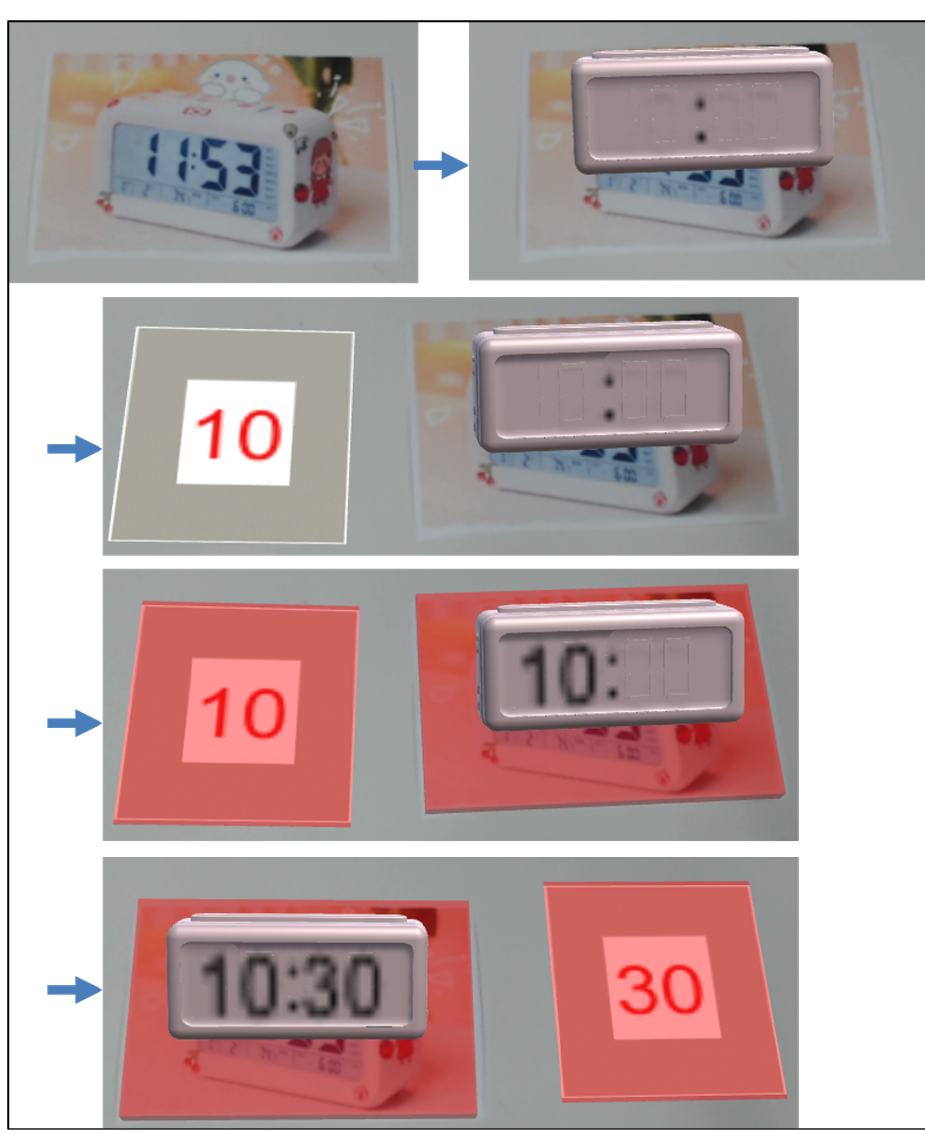
Figure 10. Using markers to control the virtual timer. The first picture shows the virtual timer marker. The second picture shows the initial state of the virtual timer superimposed on the marker. In the third and fourth pictures, the user connects the two-digit number virtual marker and the virtual timer marker to set the left parameter of the virtual timer. Similarly, the user can set right parameter of the virtual timer, as shown in the fifth figure. After the setting is completed, the virtual timer will automatically start